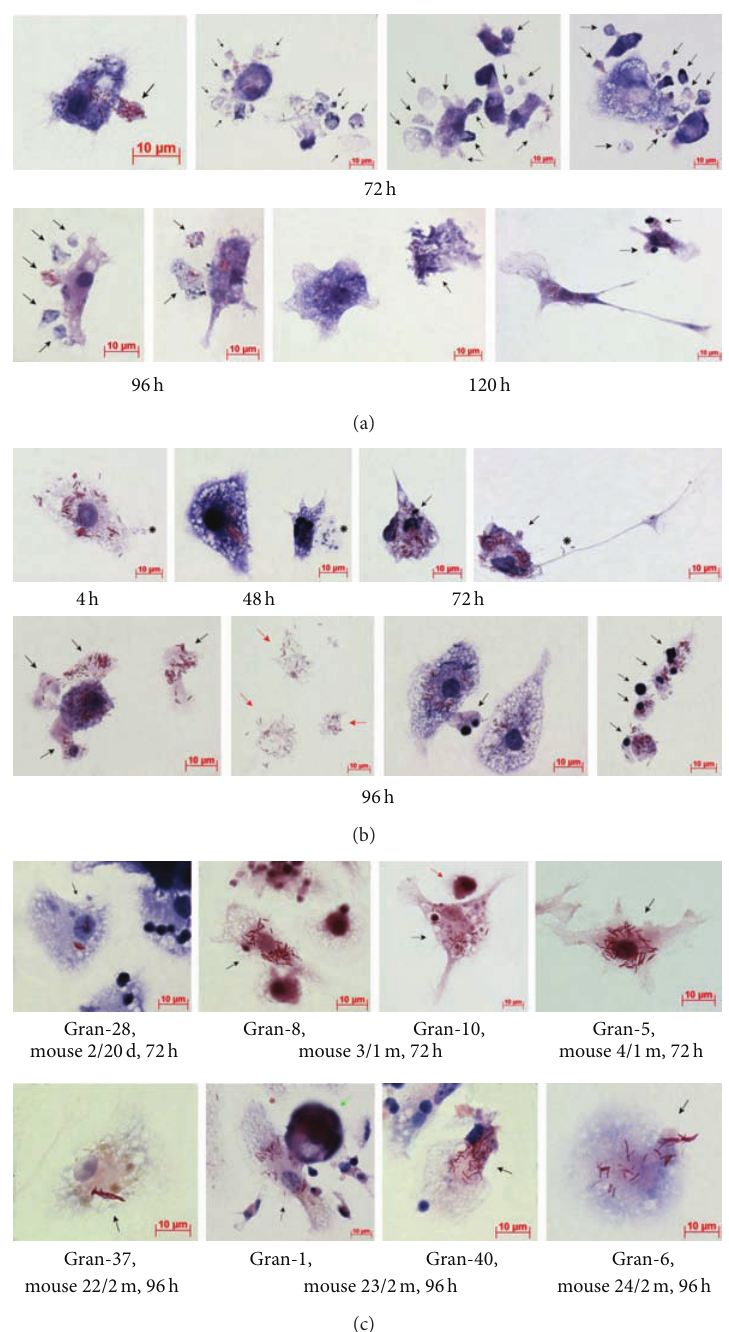
Figure 3: Dead (apoptotically or necrotically) and live macrophages containing an increased number of BCG-mycobacteria. Acid-fast BCG- mycobacteria stained by the ZN method. The scale bars are 10 𝜇 m each. ((a)-(b)) Cells with the largest number of BCG-mycobacteria and morphological evidence of death in the cultures of mouse (a) bone marrow and (b) peritoneal macrophages following infection with the BCG vaccine in vitro and after culture for several hours. Apoptotic bodies and pieces of the macrophage cytoplasm with or without acid- fast BCG in them are indicated by the black arrows. Cells containing the largest number of BCG-mycobacteria and no nuclei are indicated by the red arrows. Nonacid-fast BCG-mycobacteria (blue color) expelled by macrophages into the extracellular space are indicated by the black snowflakes. (c) Macrophages with the largest number of BCG-mycobacteria in them and without morphological evidence of death are indicated by the black arrows in the fragments of mouse splenic granulomas. The red arrow indicates a dendritic cell with BCG-mycobacteria in it; the green arrow indicates a megakaryocyte. Abbreviations as in Figure